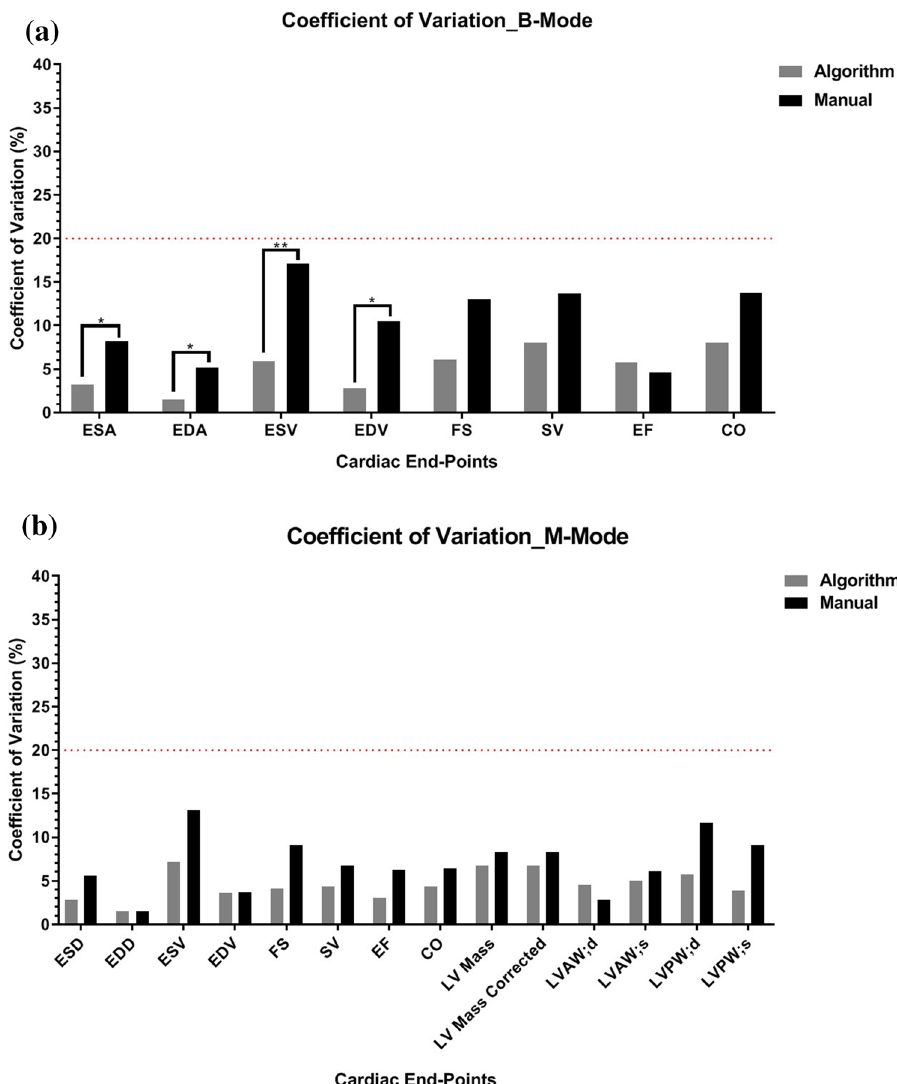
Figure 6. Analysis of variation: coefficient of variation analysis displaying coefficient of variation percentage on the y-axis and LV structural and functional end-points on the x-axis. Dark gray bars represent analysis performed using the semi-automated algorithm and black bars represent use of manual segmentation. Red dotted line shows internally set limit of variation percentages. ( a ) Details variation observed with long axis B-mode evaluation. ( b ) Details variation observed with short axis M-mode evaluation. Student within-subject t-tests were done on each cardiac end-point; *p < 0.05; **p <